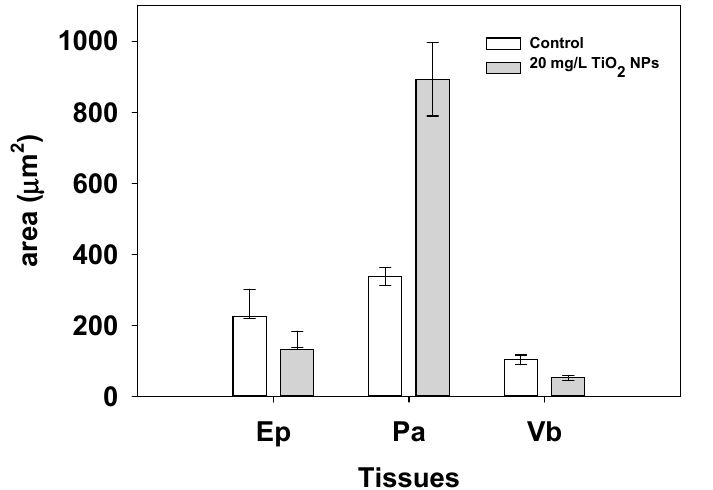
Figure 7. Tissue area of the tomato root control and the root exposed at 20 mg/L of TiO 2 NPs for Ep, Pa, Vb. Bars indicate standard errors.